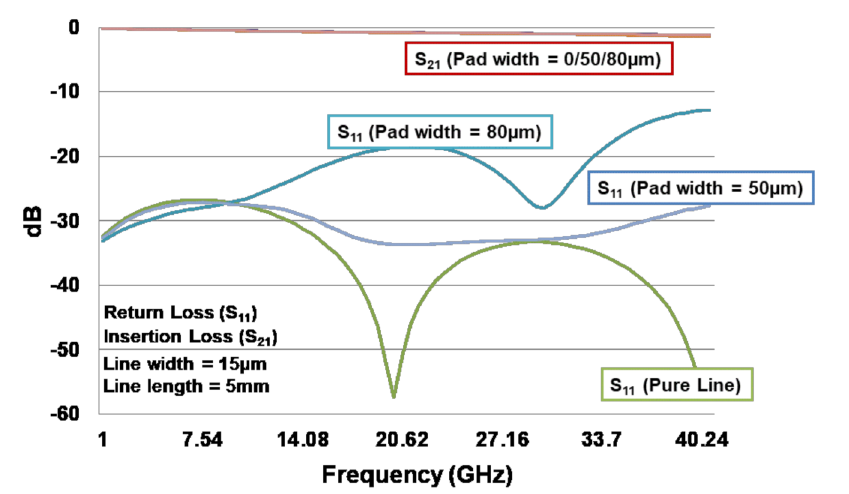
Figure 11. Return loss (S 11 ) and insertion loss (S 21 ) of test vehicle with Dk and Df from vendor 1